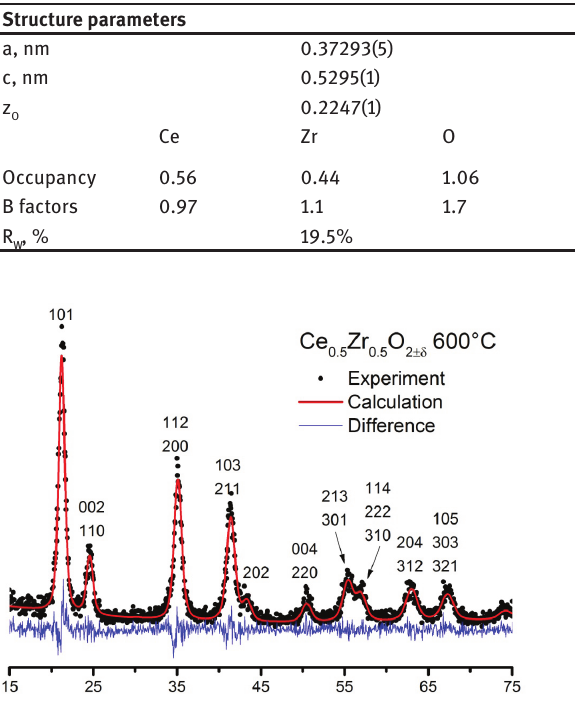
Zr O sample 0.5 0.5 2±δ